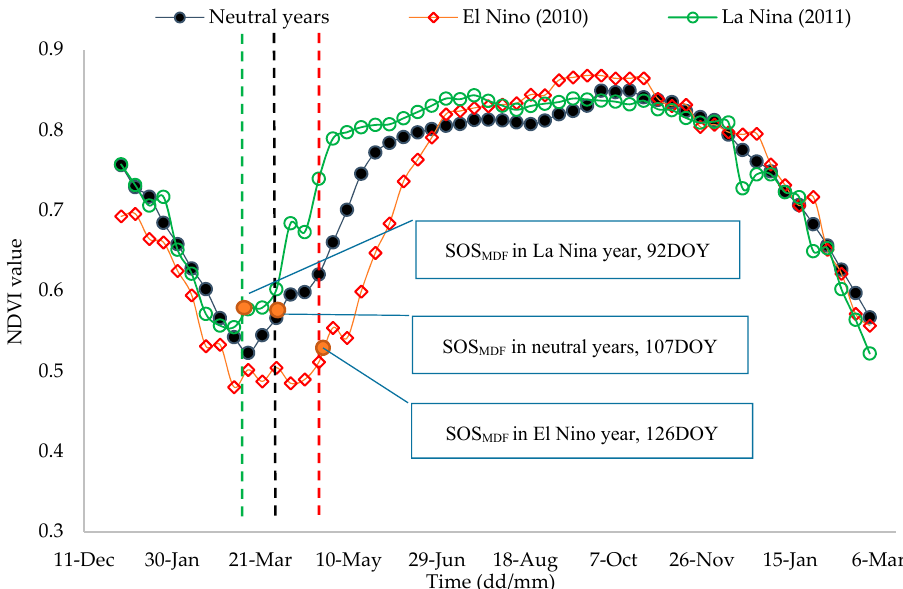
Figure 11. An example of difference in phenological metrics among El Niño (Year 2010), La Niña (Year 2011) and Neutral years at group pixels of MDF derived from MODIS NDVI.